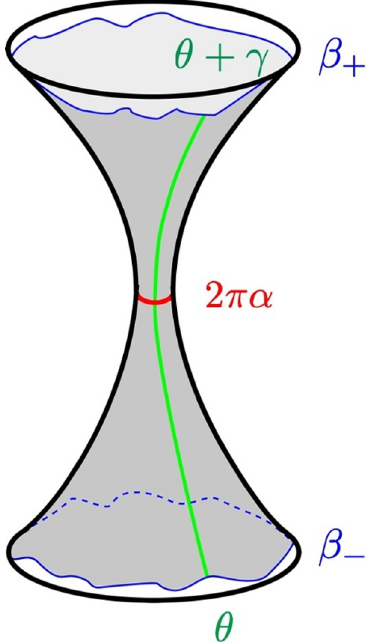
Figure 13 . Schematic diagram of global dS 2 . The asymptotic boundaries have lengths (cid:12) + and (cid:12) (cid:0) , there is a minimal length geodesic of length 2 (cid:25)(cid:11) , and there is a twist (cid:13)